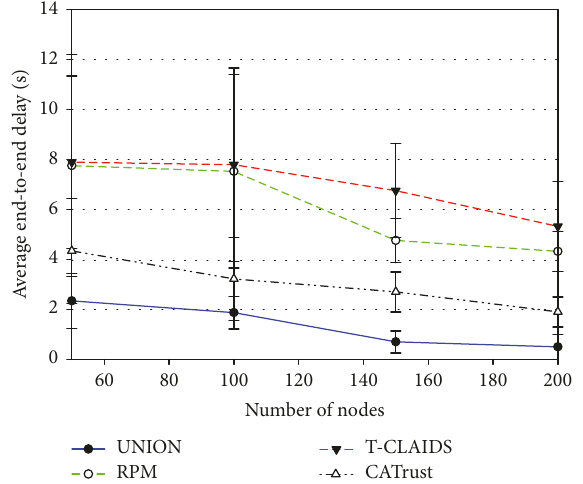
Figure 10: 𝑈𝑁𝐼𝑂𝑁 intentional and unintentional dishonesty detec- tion compared to 𝑅𝑃𝑀 in the presence of 25% dishonest UAVs.